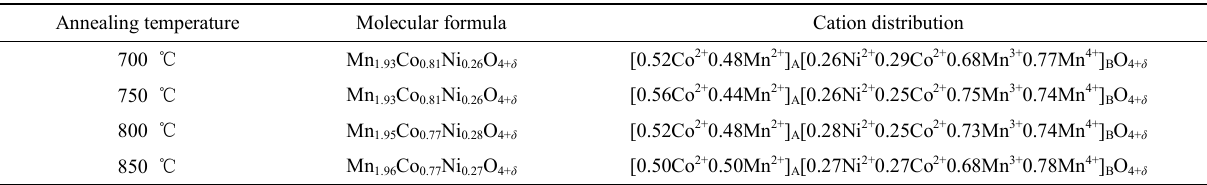
Fig. 6 XPS spectra of (a) Co 2p and (b) Ni 2p level signals of MCNO thin films at different annealing temperatures. Table 3 Molecular formula and cation distribution of MCNO thin films at different annealing